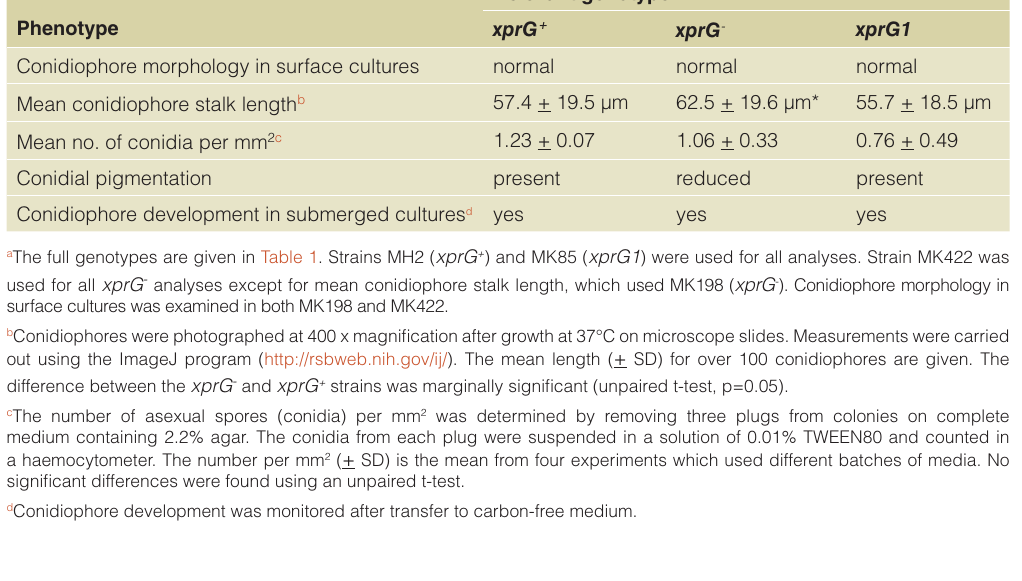
(Figure 8C). xprG2 ndtA D double mutants had the same pale conid- ia as xprG2 strains. Like the xprG2 single mutant, the xprG2 ndtA D double mutant produced no halo on medium containing milk as a carbon or nitrogen source and did not undergo autolysis in response to nutrient stress (Figure 7).